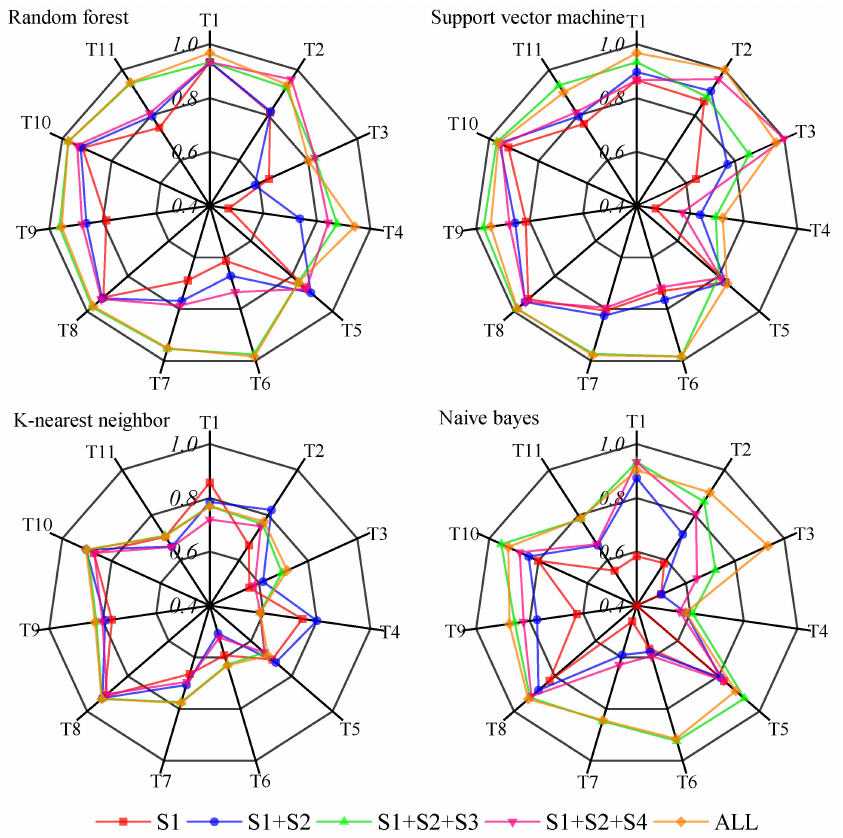
Figure 3. F1 score of pixel-based classifiers under different feature combinations.